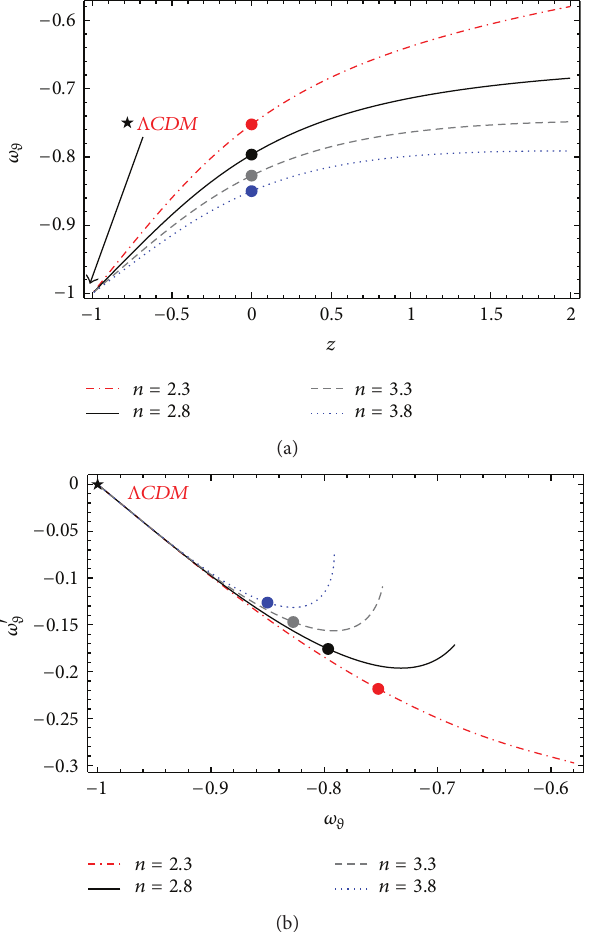
Figure 6: Evolution trajectories in NADE for (a) 𝜔 𝜗 versus 𝑧 and (b) 𝜔 󸀠 𝜔 − 𝜔 󸀠 𝜔 𝜗 and 𝜗 𝜗 in 𝜗 plane with